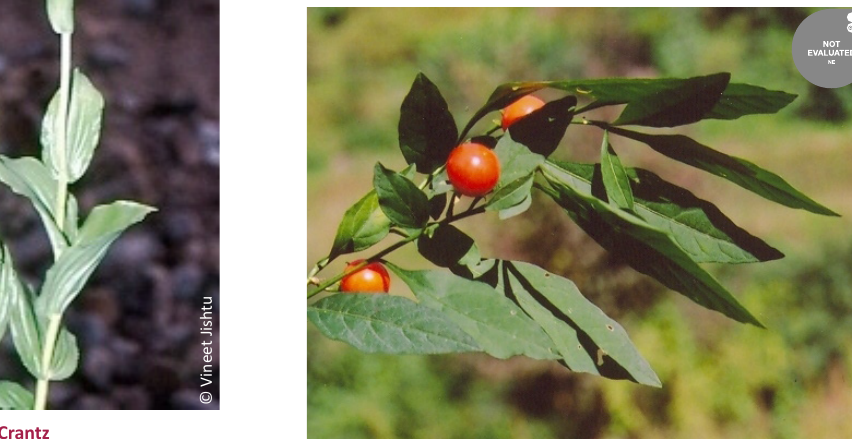
Image 43. Solanum pseudocapsicum